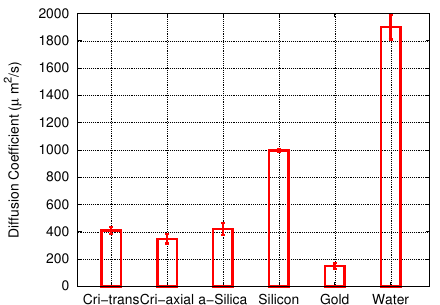
Figure 4. Diffusion coefficients of cisplatin (cis) in different pore materials and in water. Error bars were obtained from the uncertainty of the fit of the slope D in Equation (1).